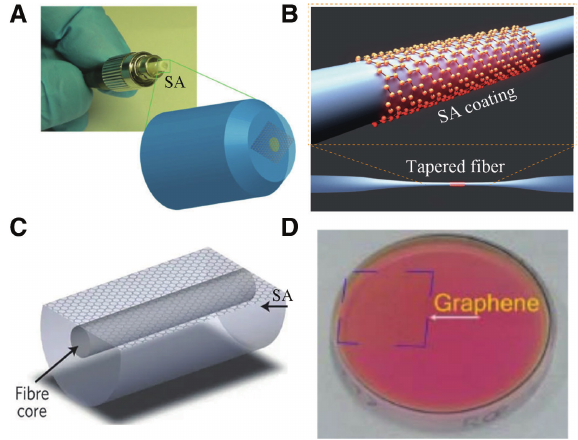
Figure 7: Various integration strategies of nanomaterial SAs. (A) Sandwiching SAs between two connectors. (B) Coating SAs on tapered fibers. (C) Coating SAs on D-shaped fibers. (D) Integration on the dielectric flat mirror. (A) Reproduced from Ref. [16], Copyright 2009, Wiley-VCH. (B) Reprinted from Ref. [167], Copyright 2016, Macmillan Publishers Ltd. (C) Adapted from Ref. [168], Copyright 2013, Macmillan Publishers Ltd. (D) Reprinted from Ref. [169],